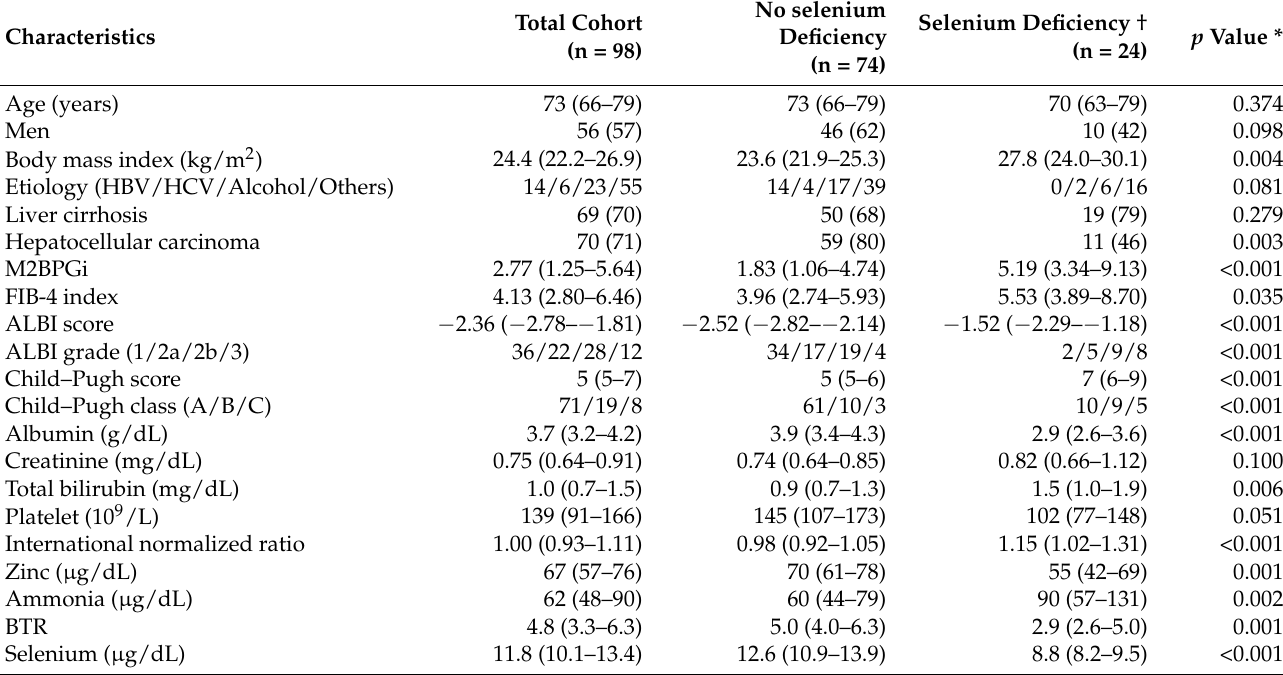
Table 1. Clinical characteristics of patients with and without selenium